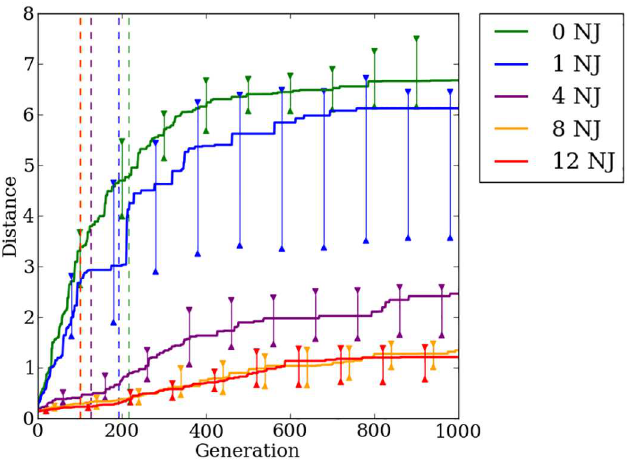
Fig 17. The median distance traveled by Auto-Switch-HybrID generation champions over 1,000 generations on the quadruped robot experiment. The line colors indicate the numberof noisy joints on the robot. The median switch points per treatment are indicatedby dashed lines. 95% bootstrapped confidence intervals of the medianare shown every 100